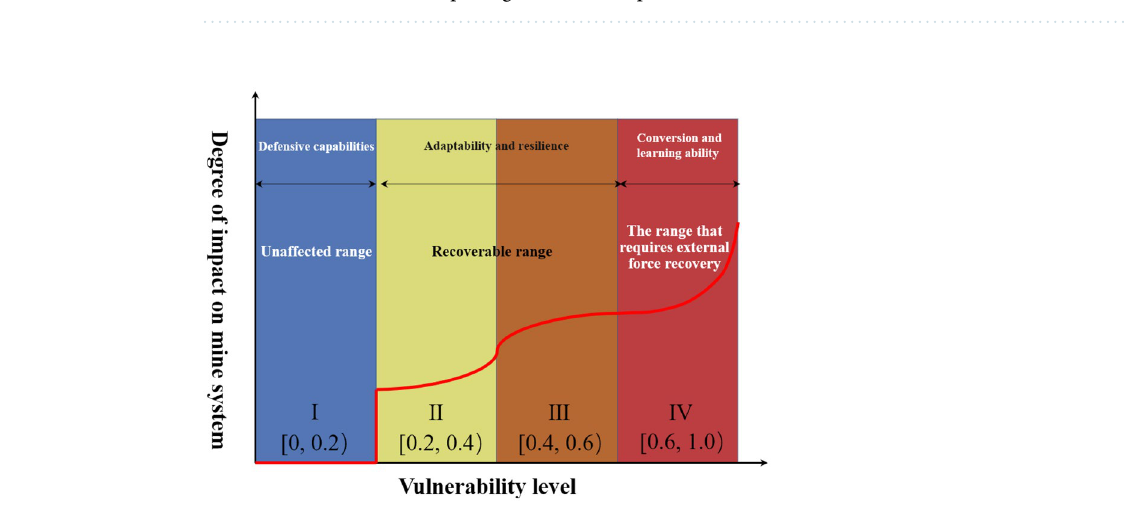
Table 5. Roof fall and rib spalling accident risk point.